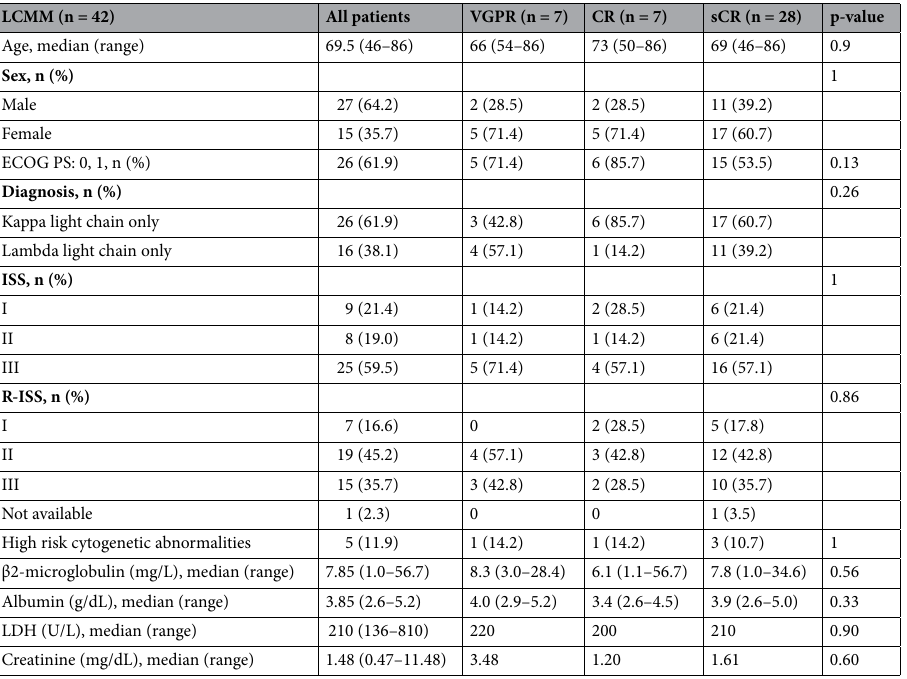
Table 1. Baseline characteristics of patients with LCMM. LCMM: Light chain multiple myeloma; ECOG: Eastern Cooperative Oncology Group; PS: performance status; ISS: international staging system; R-ISS: revised international staging